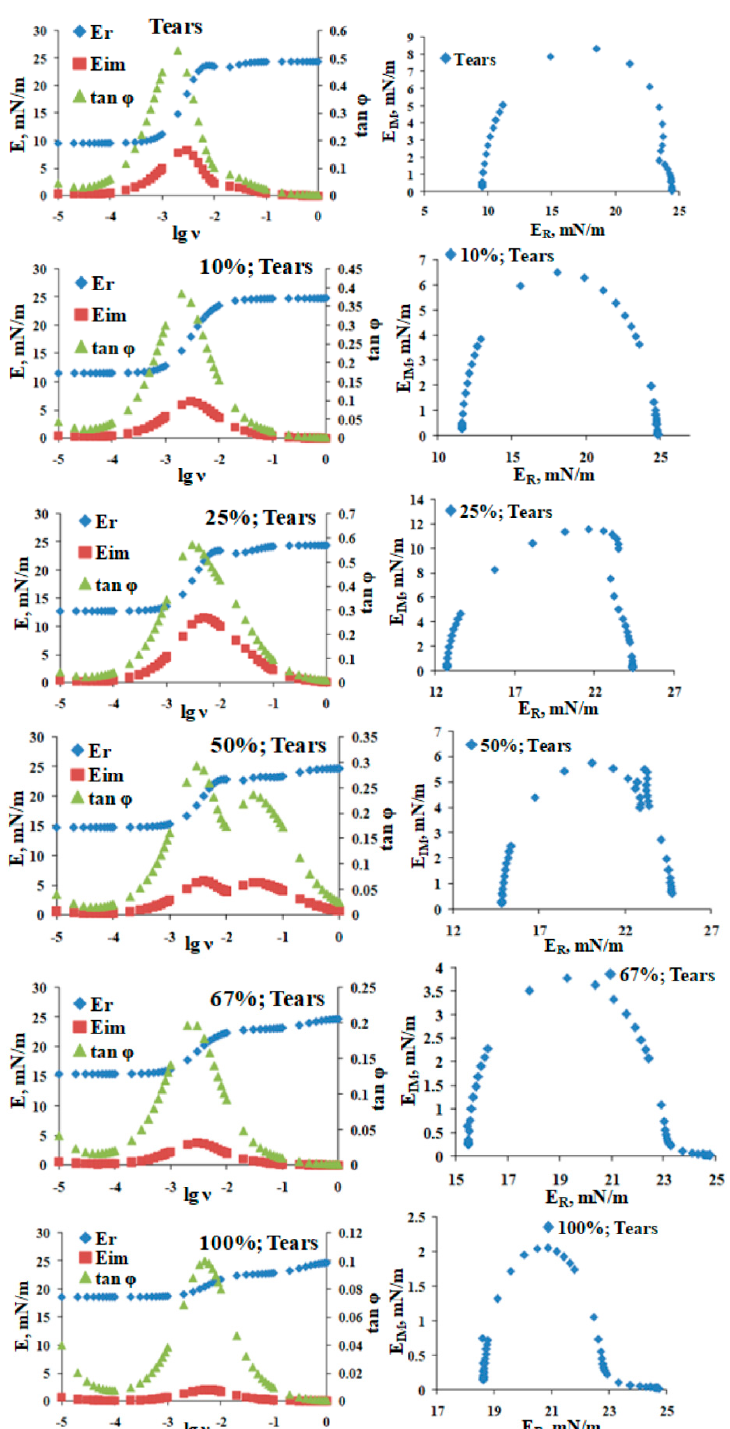
Figure 8. Rheological parameters obtained by Fourier transformation of the relaxation transients from Figure 7. Right panels denote the frequency dependences of the real and imaginary part of the complex modulus and of the tangent of the phase angle; the left panels show Cole–Cole plots of E IM vs. E R . The % denotes the degree of tear lipid saturation.